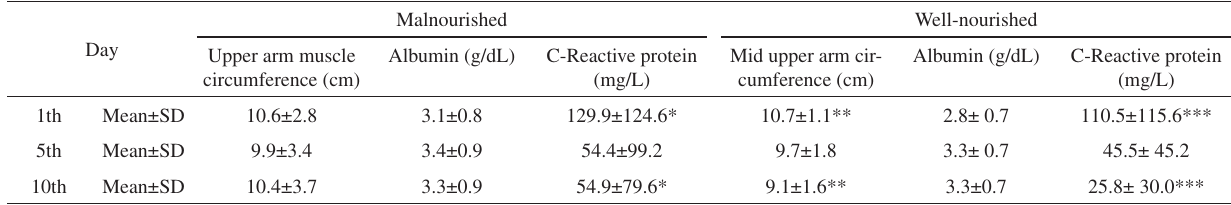
Table 4 - Means values of upper arm muscle circumference, concentrations of albumin and C-reactive protein in malnourished and well-nourished patients during the study